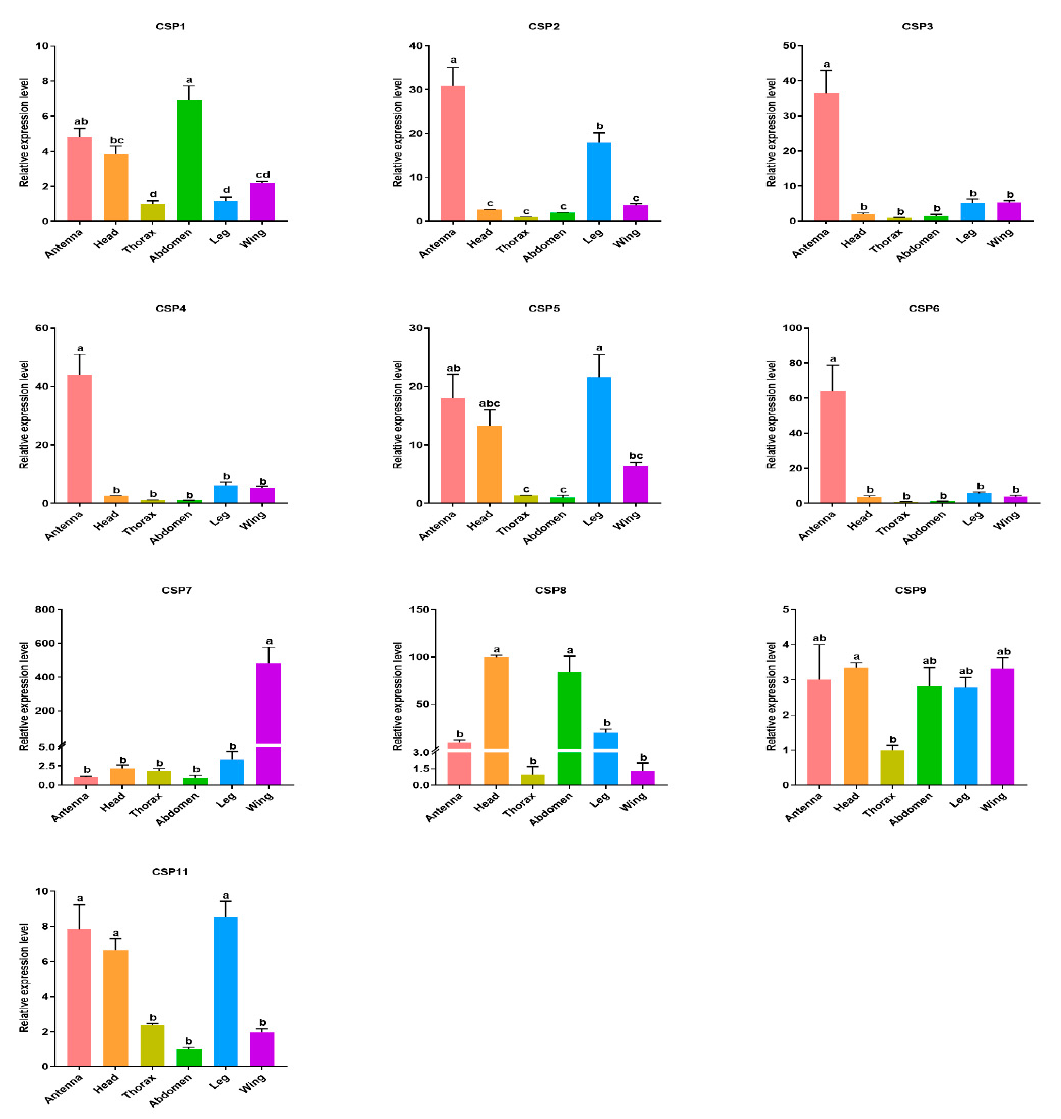
Figure 6. Relative expression levels of CSPs in different tissues of N. cincticeps analyzed by qRT-PCR. Four biological replicates were conducted for each experiment. The relative quantification was calculated using the comparative 2 − ∆∆ Ct method. The comparative analysis of each CSP genes among various tissues were determined using one-way tested analysis of variance (ANOVA), followed by Tukey’s multiple range test ( p < 0.05). Different lowercase letters indicate significant differences between different tissues. The values were presented as the mean ± standard error.